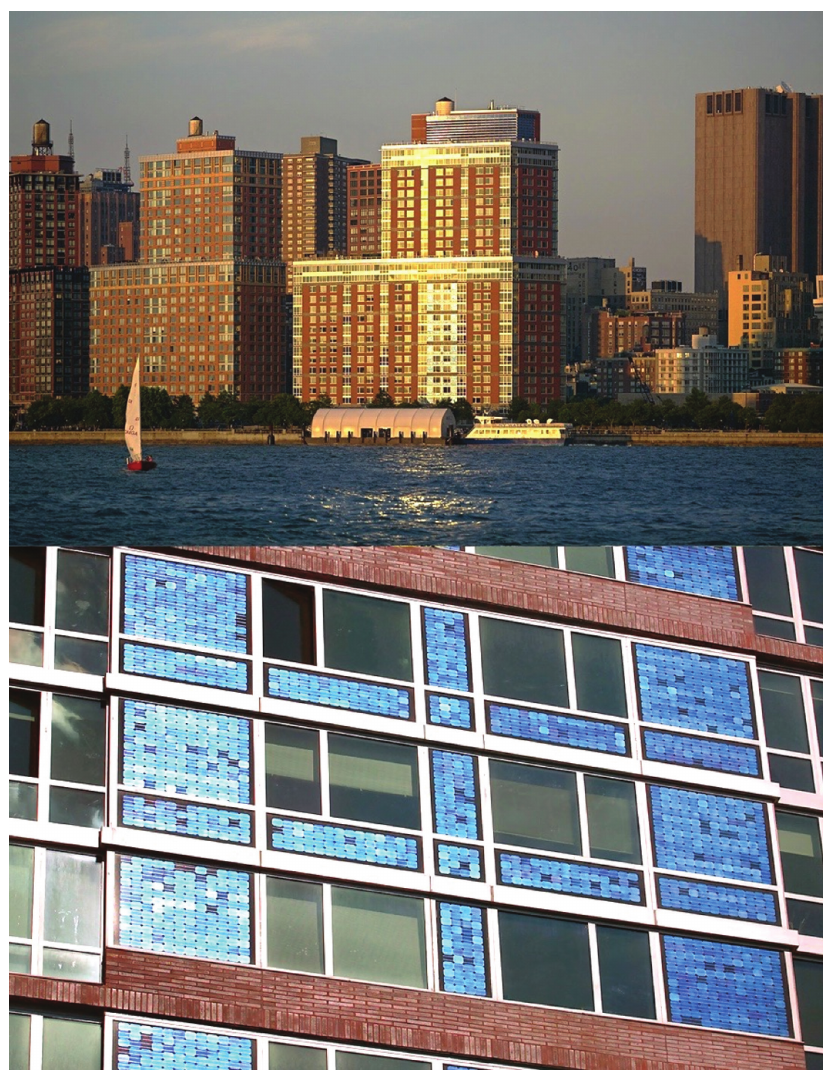
Figure 1. The Solaire by Pelli Clarke Pelli, New York (2002). A fully air-conditioned LEED Platinum rated residential high-rise. A trade-off between socio-territorial equilibrium and energetic gains © Jeff